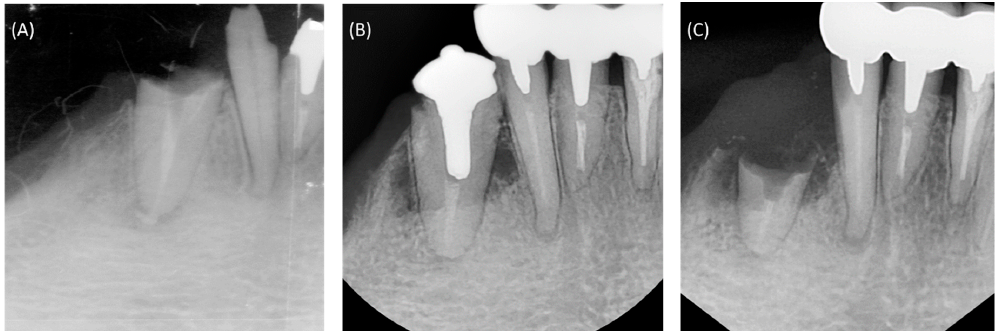
Figure 1. Intraoral periapical radiographs of the patient’s mandibular right anterior dentition. ( A ) At initial presentation, the canine had a subgingival fracture and prior root canal treatment. ( B ) The root canal